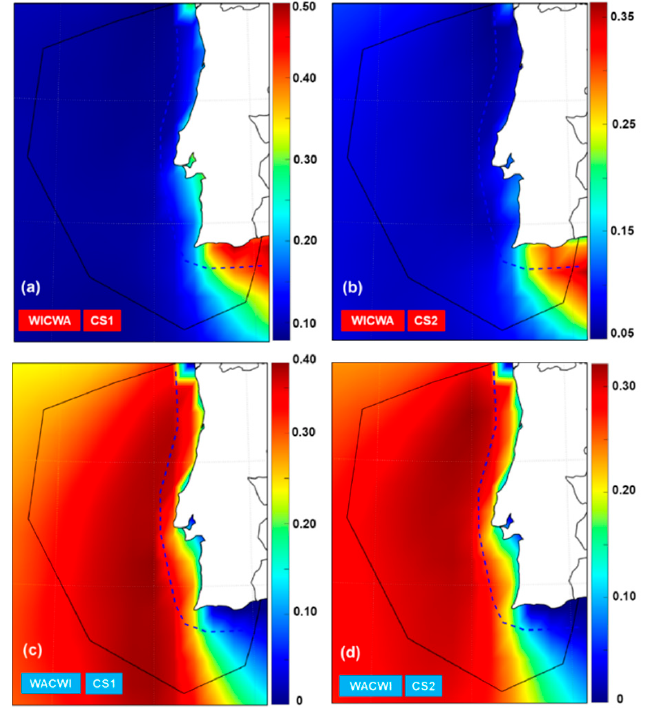
Figure 8. Spatial maps illustrating: ( a , b ) wind-wave power complementarity (WICWA)—case studies 1 and 2, respectively; ( c , d ) wave-wind complementarity (WAWI)—case studies 1 and 2, respectively.